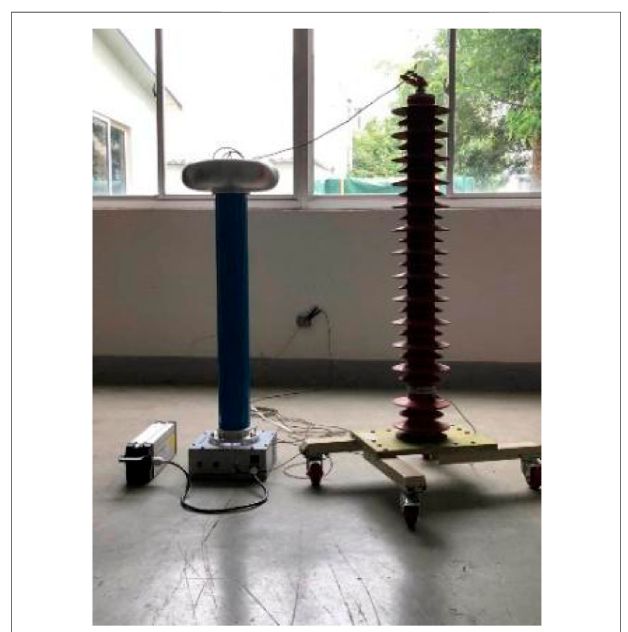
FIGURE 5 | Laboratory wiring